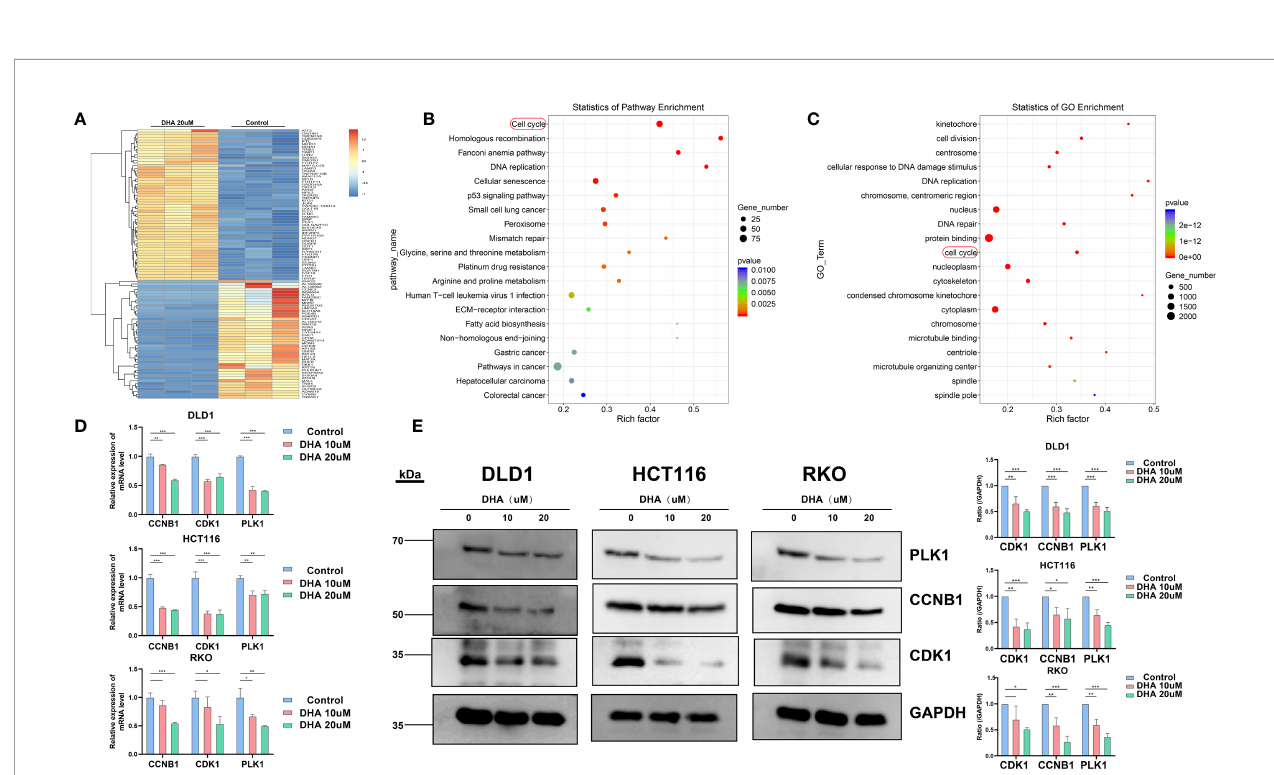
FIGURE 4 | DHA regulated CDK1/CCNB1/PLK1 signaling in CRC cells. (A) A heatmap showing the top 100 DEGs in DHA-treated CRC cells. (B, C) KEGG and GO analyses of the targeted of DHA in CRC cells. (D, E) qRT-PCR and Western blotting analysis of the effects of DHA on the expression of CDK1, CCNB1, and PLK1 in CRC cells. Data are shown as means ± SD. *p < 0.05, **p < 0.01, ***p < 0.001. DHA, dihydroartemisinin; CRC, colorectal cancer; DEGs, differentially expressed genes; KEGG, Kyoto Encyclopedia of Genes and Genomes; GO, Gene Ontology.